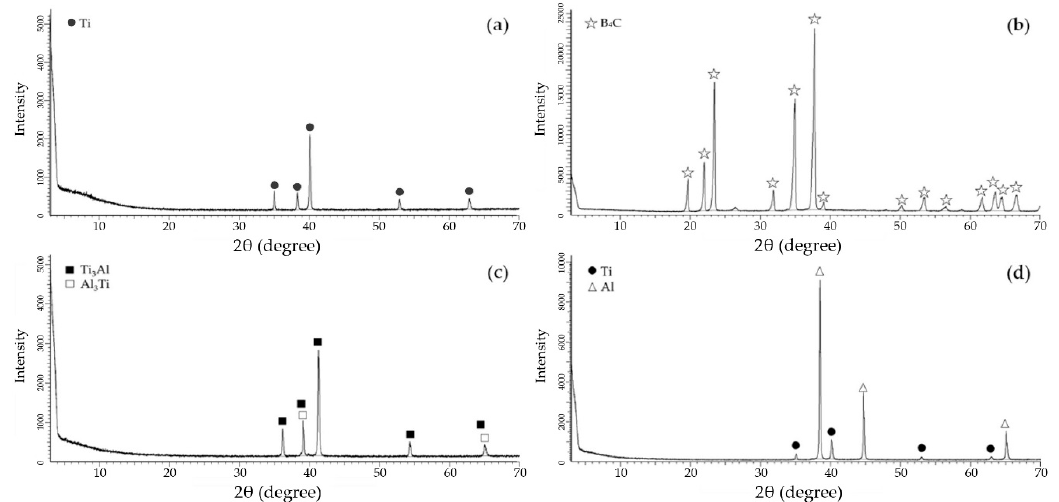
Figure 1. XRD (X-ray di ff raction) patterns of the starting powders: ( a ) Ti powder, ( b ) B 4 C particles, ( c ) Ti-Al(1) powder and ( d ) Ti-Al(2) powder.